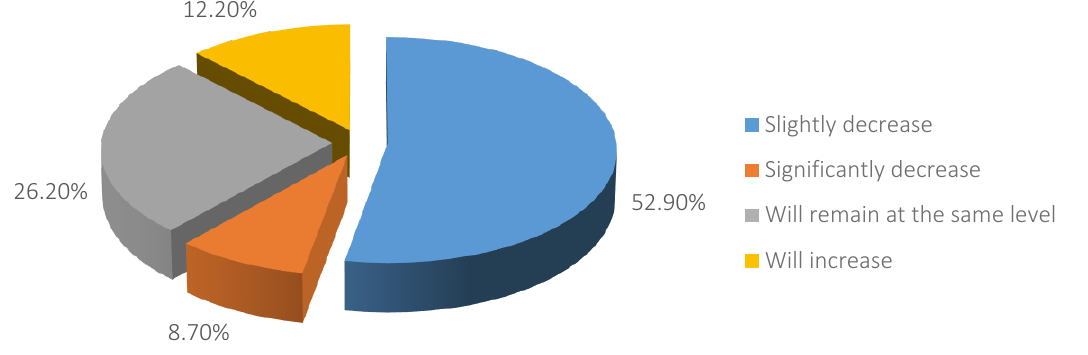
Figure 5. Respondents’ answers to the question “How can you evaluate the effectiveness of scientific activity at the university at the end of